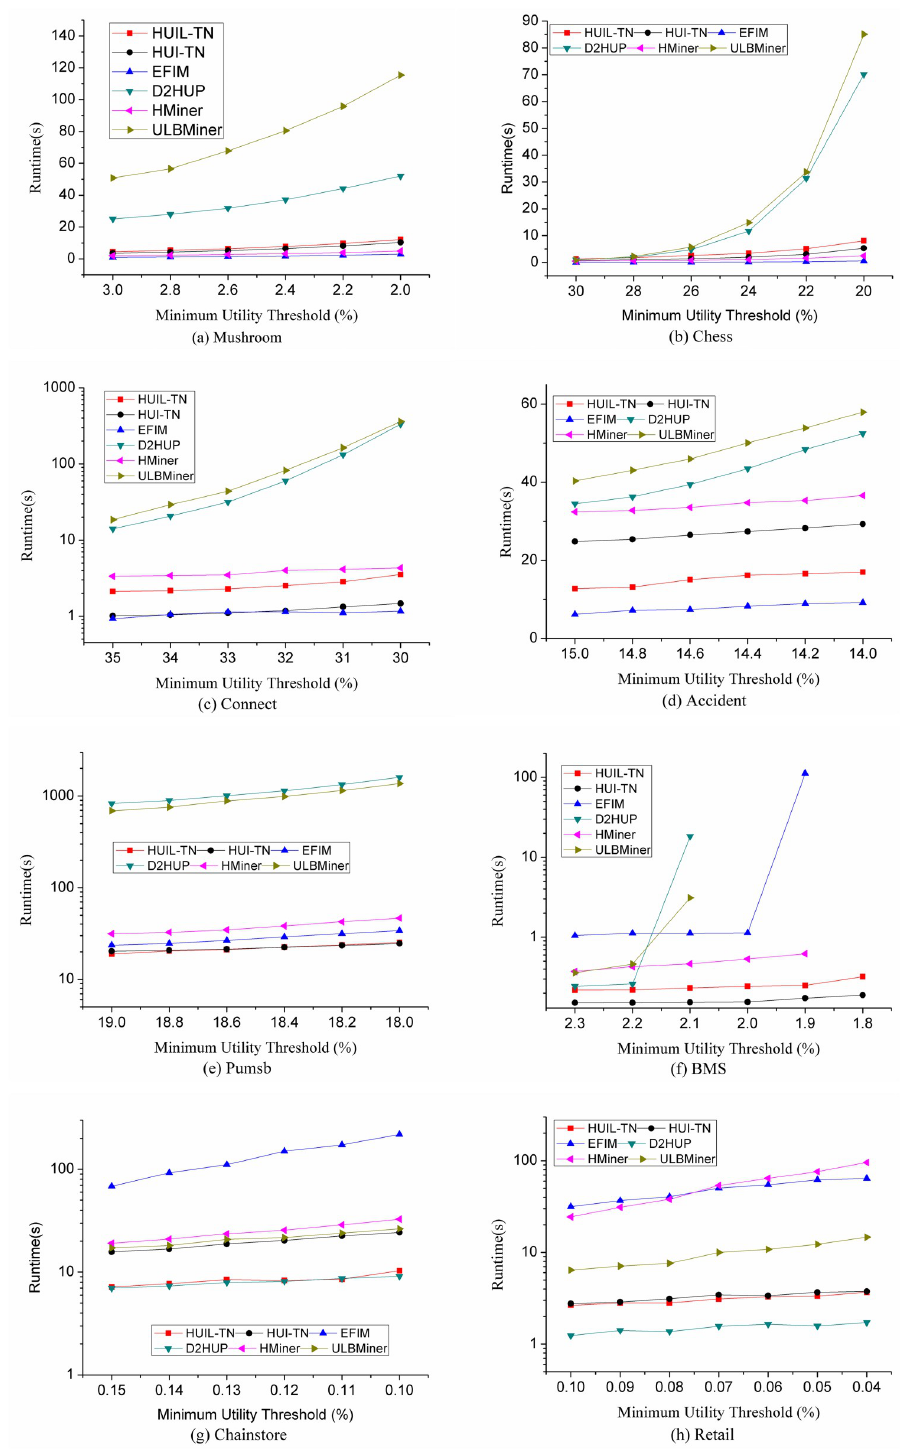
Fig 7. Comparison of